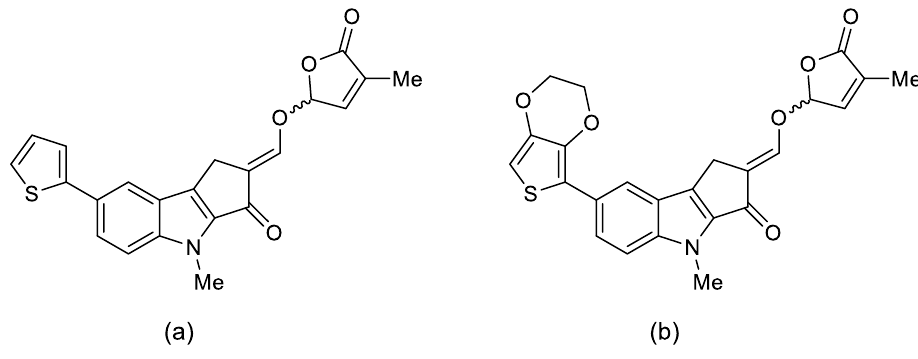
Figure 10. Structures of synthetic strigolactones: ( a ) MEB55; ( b ) ST362.